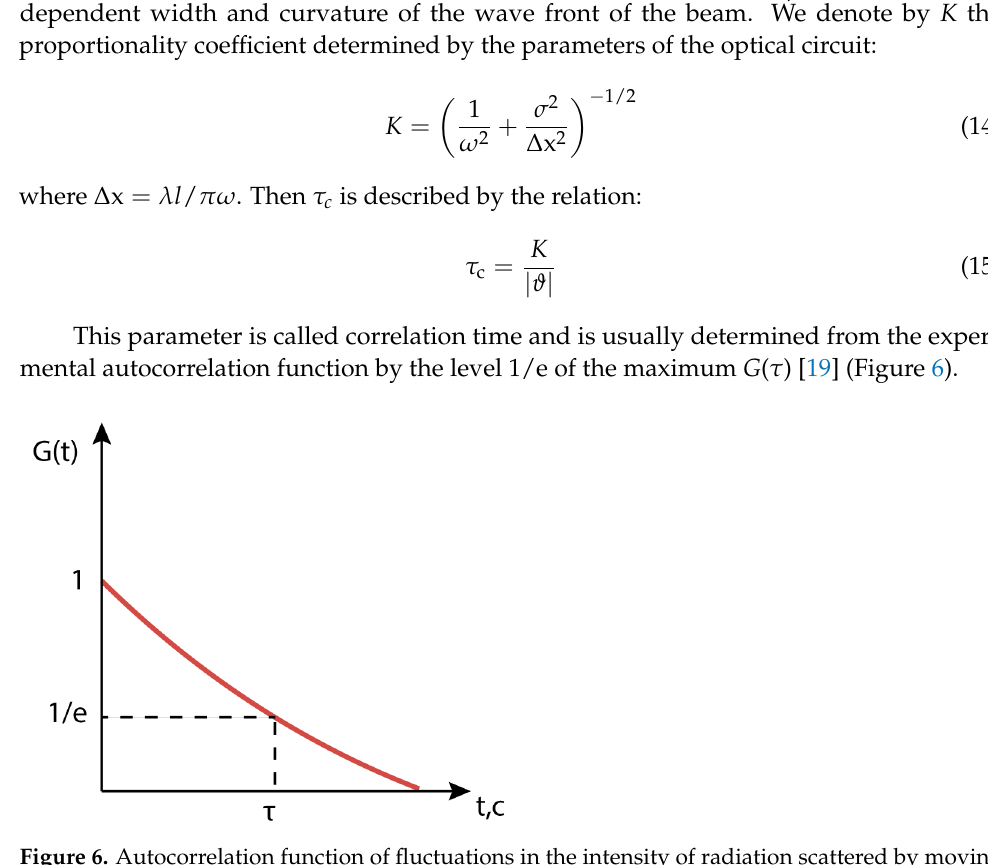
Figure 6. Autocorrelation function of fl uctuations in the intensity of radiation sca tt ered by moving objects.